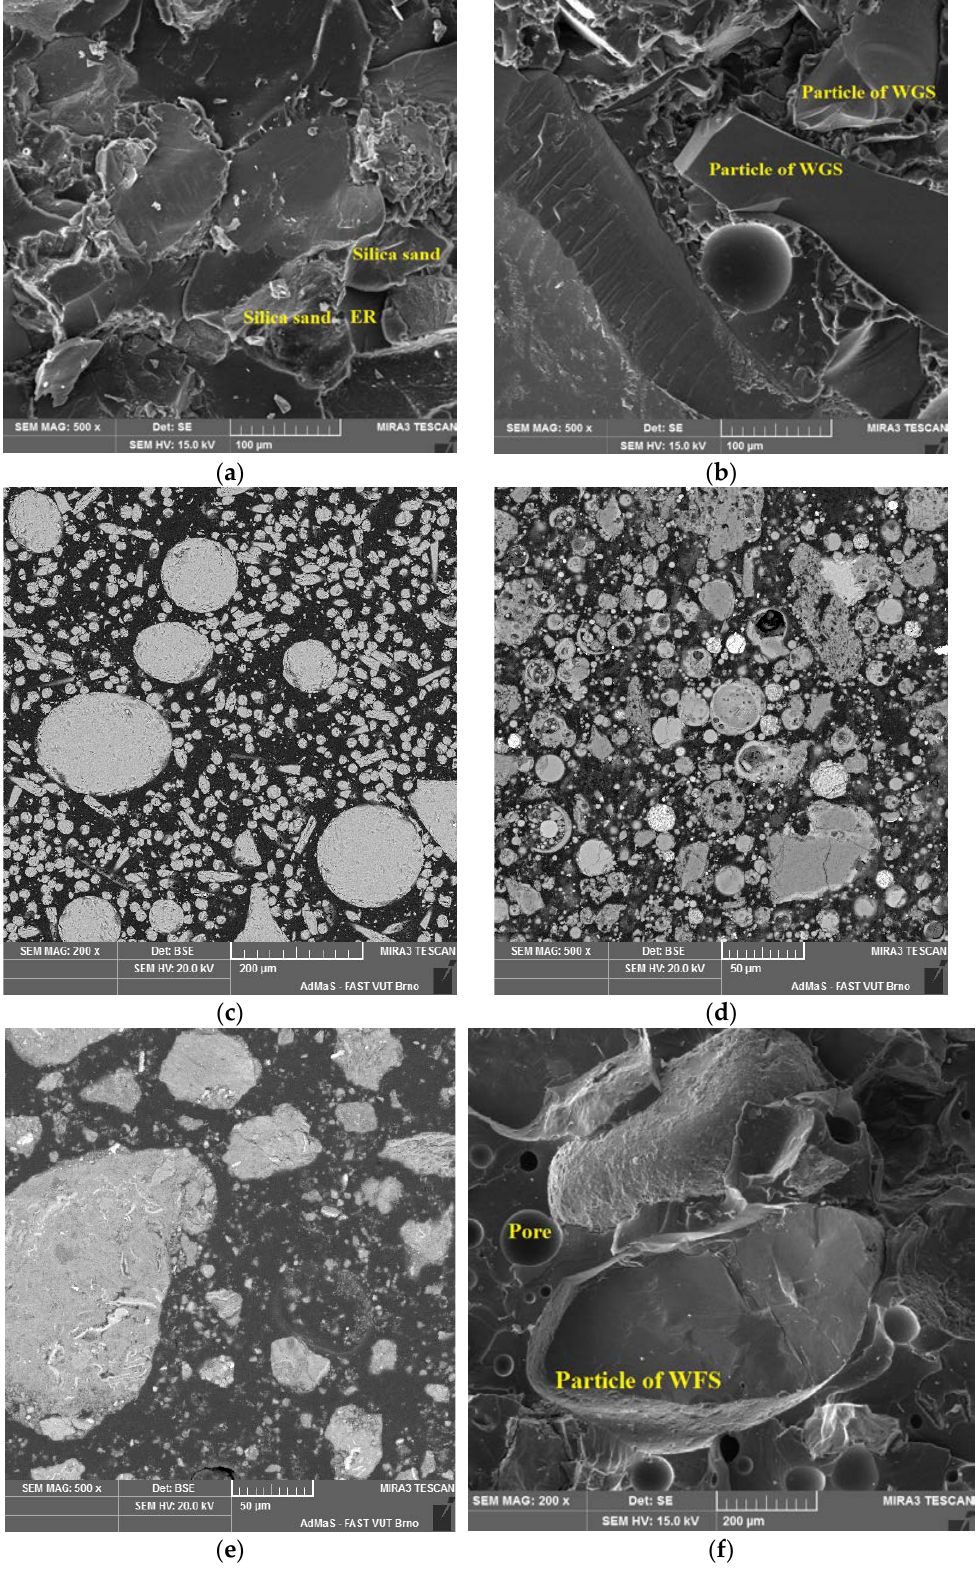
Figure 18. SEM photomicrographs of the epoxy composites with different fillers: ( a ) REF—Silica sand, 500 × ; ( b ) WGS—Waste glass from solar panels QS Solar 500 × ; ( c ) RGI—Recycle from the production of glass insulation 200 × ; ( d ) FA—Fly ash 500 × ; ( e ) NS—Neutralization sludge 500 × ; ( f ) WFS—Waste foundry sand.